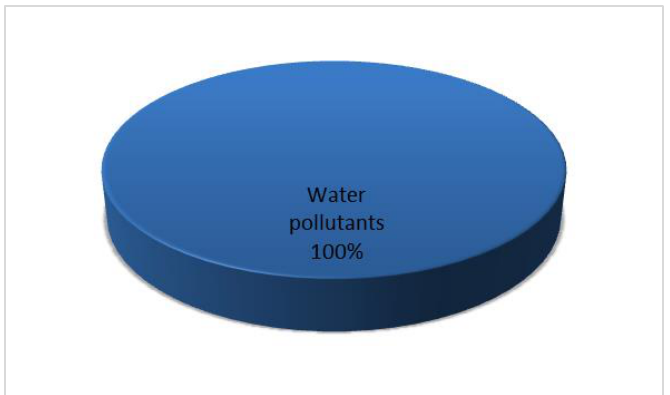
Fig. 7. Percentage of water pollutants